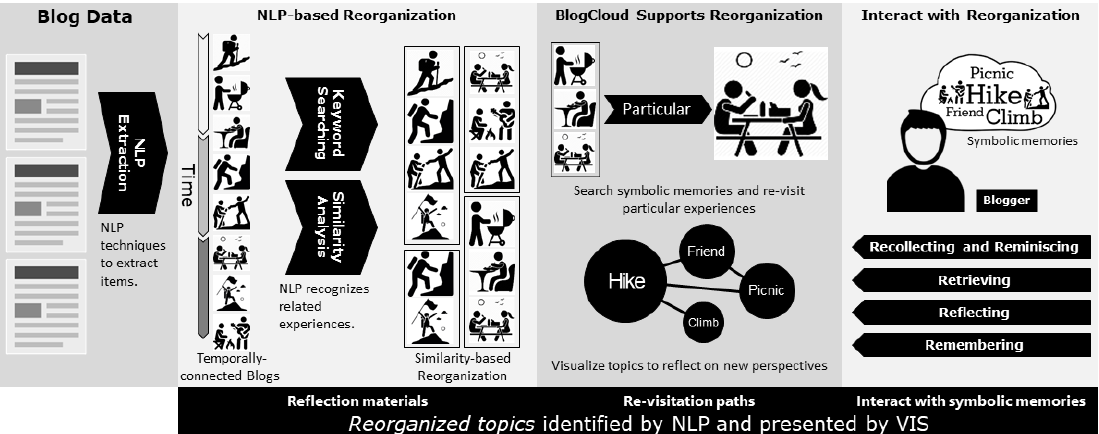
Figure 1. The conceptual description of reorganization . NLP breaks the original temporal order of blogs by keyword searching and similarity-based grouping. Bloggers can re-visit particular experiences and reflect on the visualized high-level topics. Reorganization leads to new manners to re-visit personal